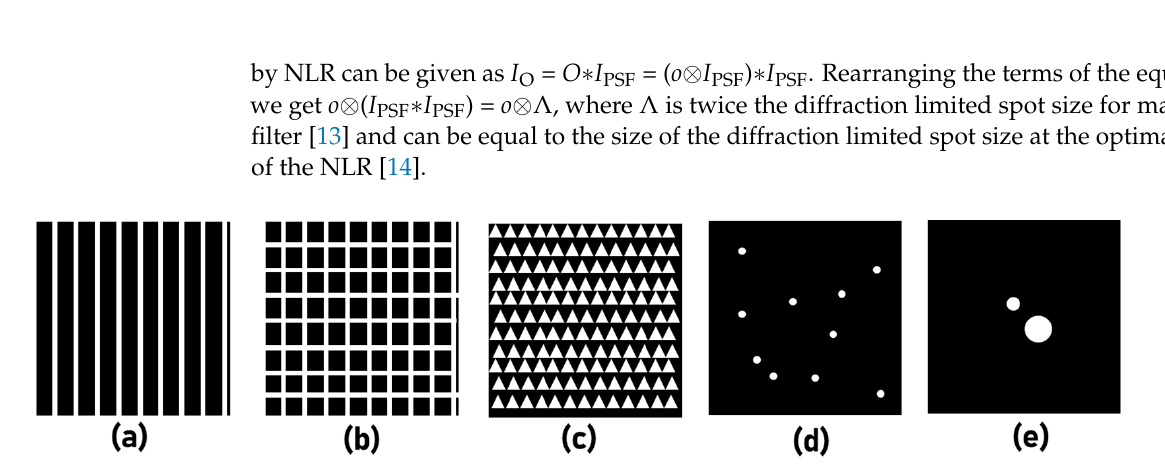
Figure 3. Intensity images of different types of occlusion ( a ) 1-D mesh, ( b ) 2D mesh, ( c ) triangular mesh and ( d ) block with randomly arranged holes. ( e ) Image of the object. The white regions indicate the opening, and the dark regions indicate the metal block.